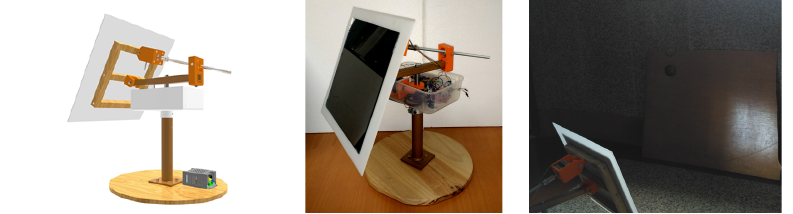
Fig. 4. Structural drawing (left), prototype (middle) and tests